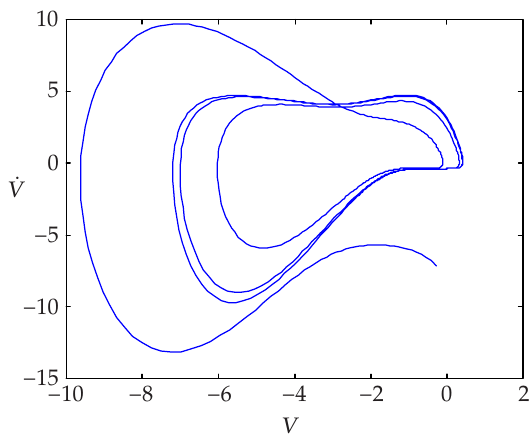
Figure 2.1 . Phase plot of the action potential and its first derivative.